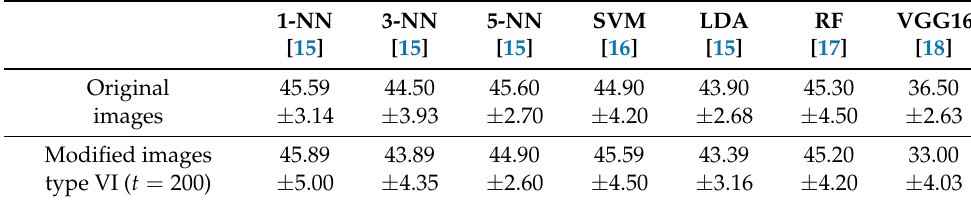
Table 5. Average error rates of classifiers on original images and modified